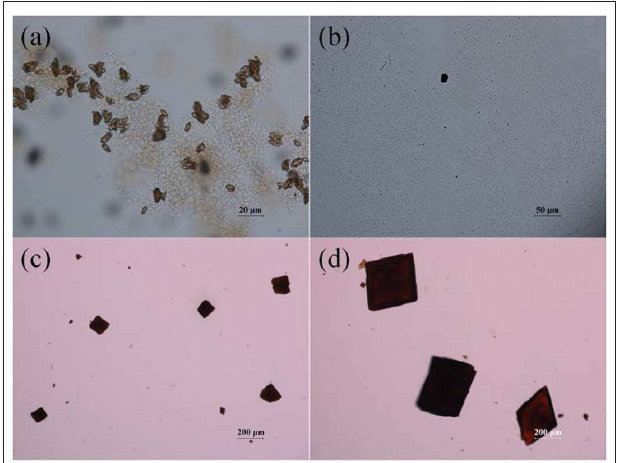
FIGURE 2 | Optical microscopic images of the products obtained from DMF without [EMIM][BF